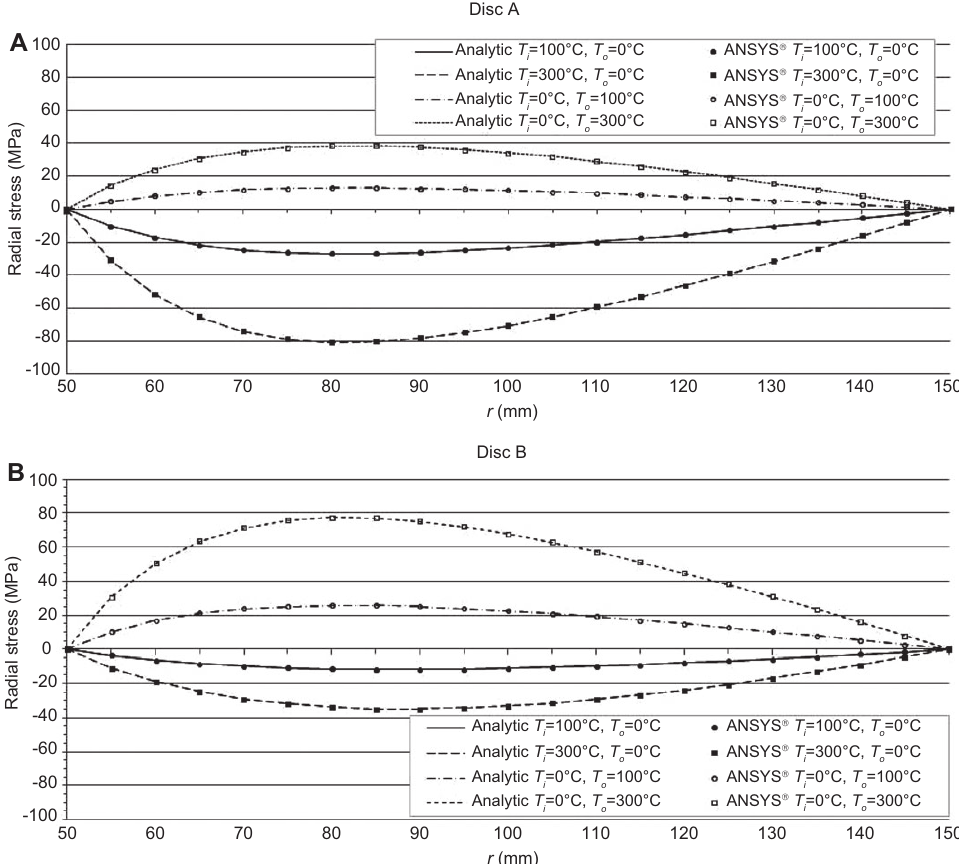
Figure 8 Variations of radial stresses at Disc A (A) and Disc B (B) under linearly increasing and decreasing